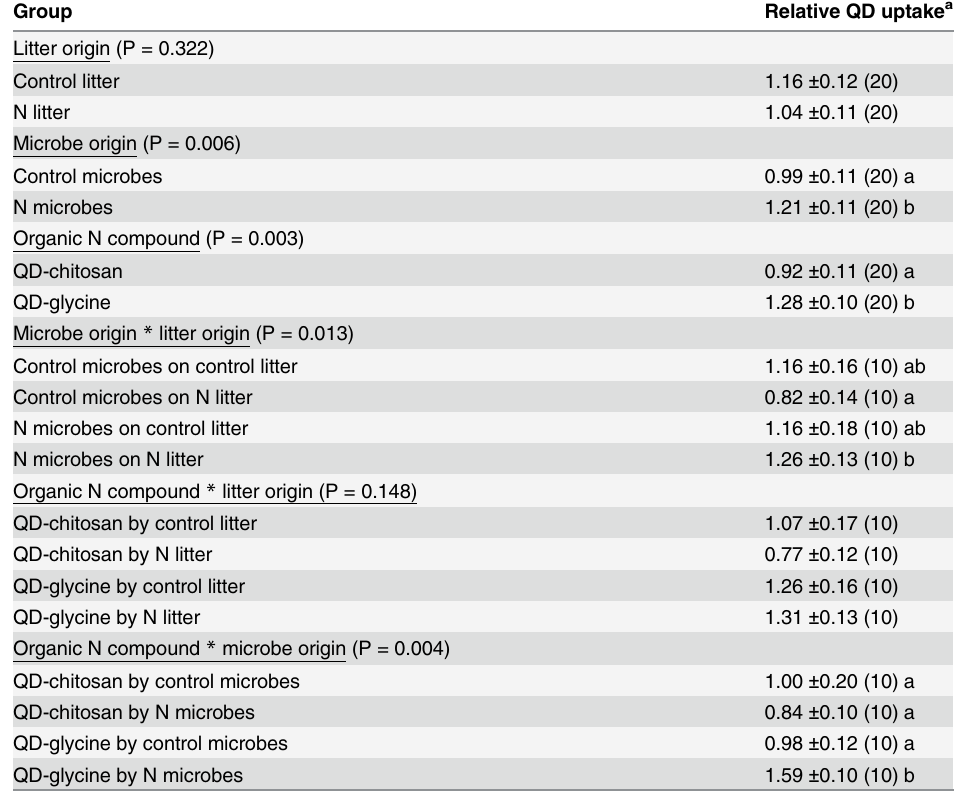
Table 1. Relative uptake capacity of QD compounds by group.